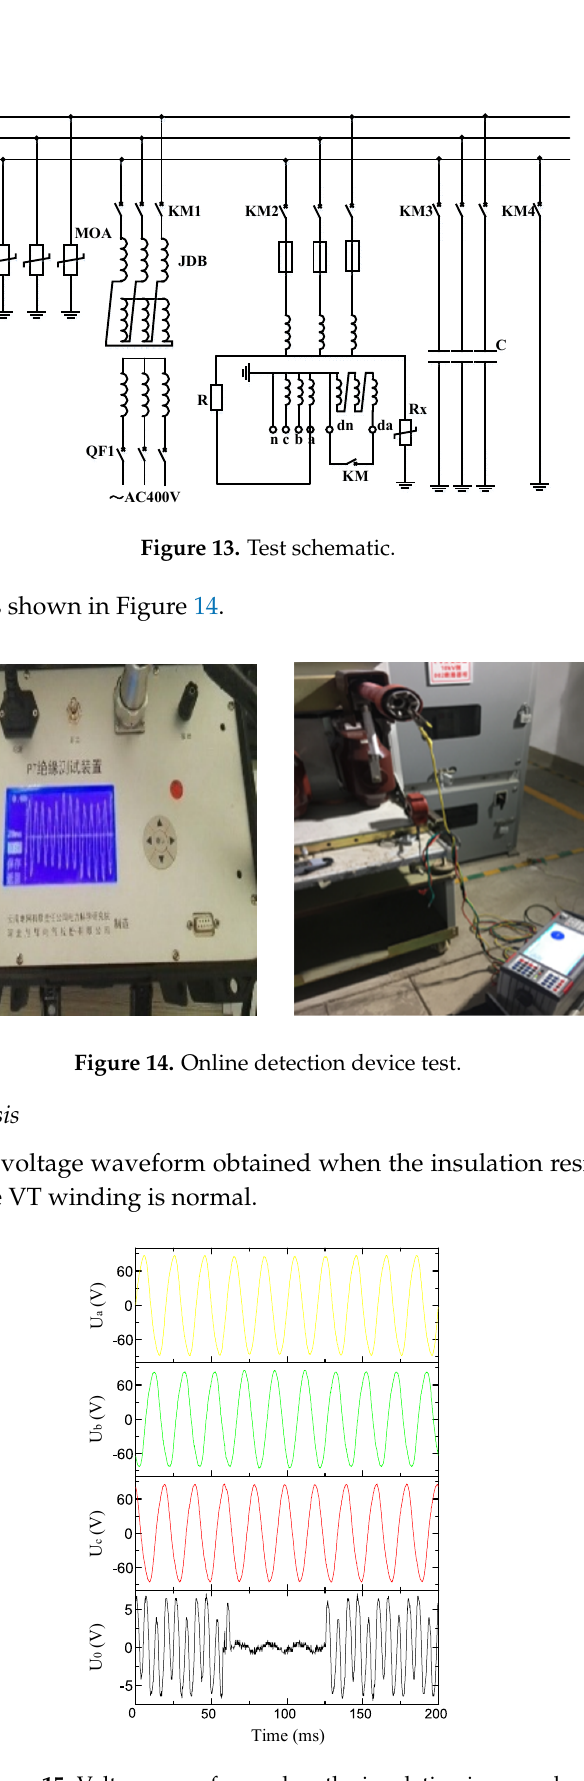
Figure 15. Voltage waveform when the insulation is normal.